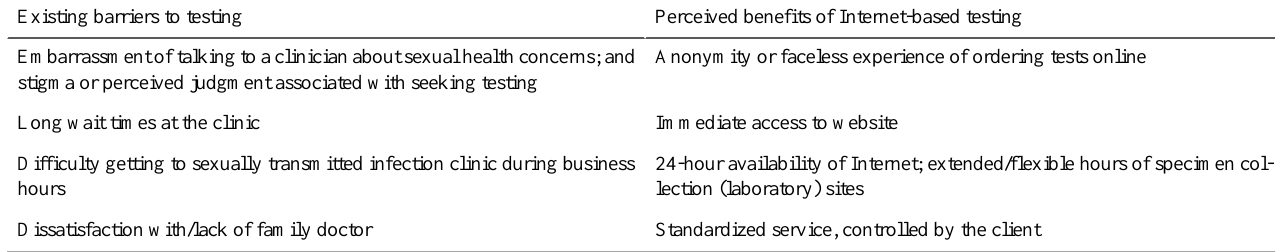
Table 2. Barriers to in-clinic sexually transmitted infection and human immunodeficiency virus testing, and corresponding benefits of Internet-based testing, as expressed by